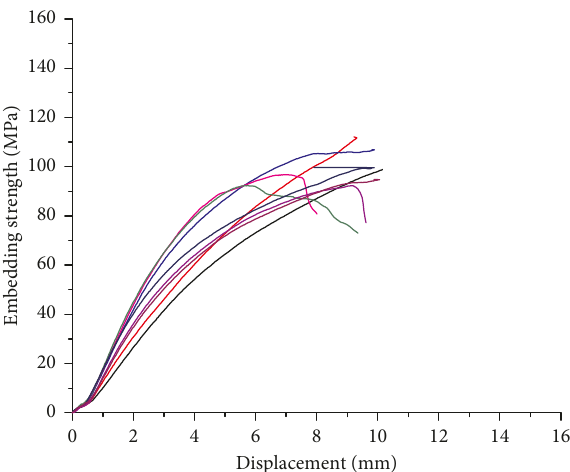
Figure 10: Strength-displacement curve of group H4.